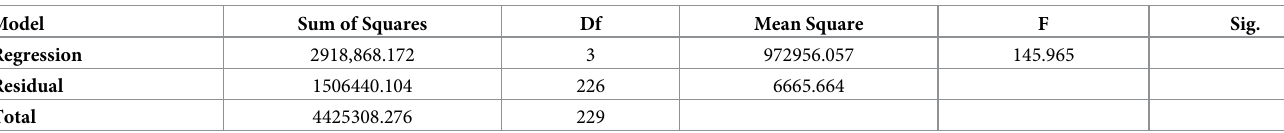
Table 8. ANOVA a test of the linear regression model.